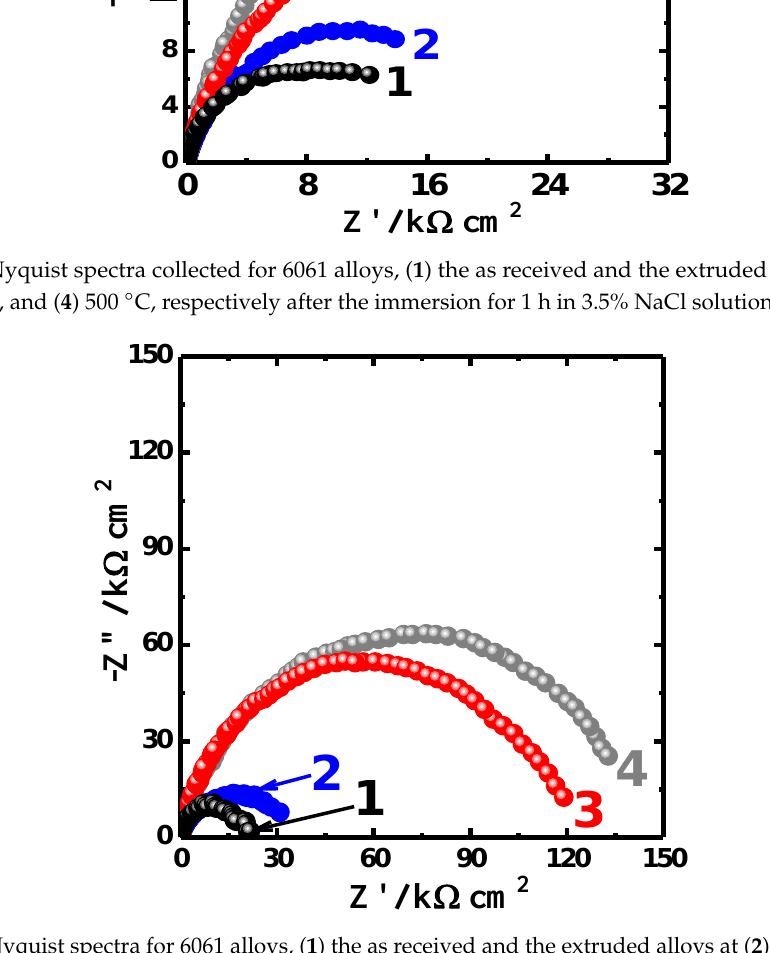
Figure 5. The circuit used in fitting the EIS experiments.